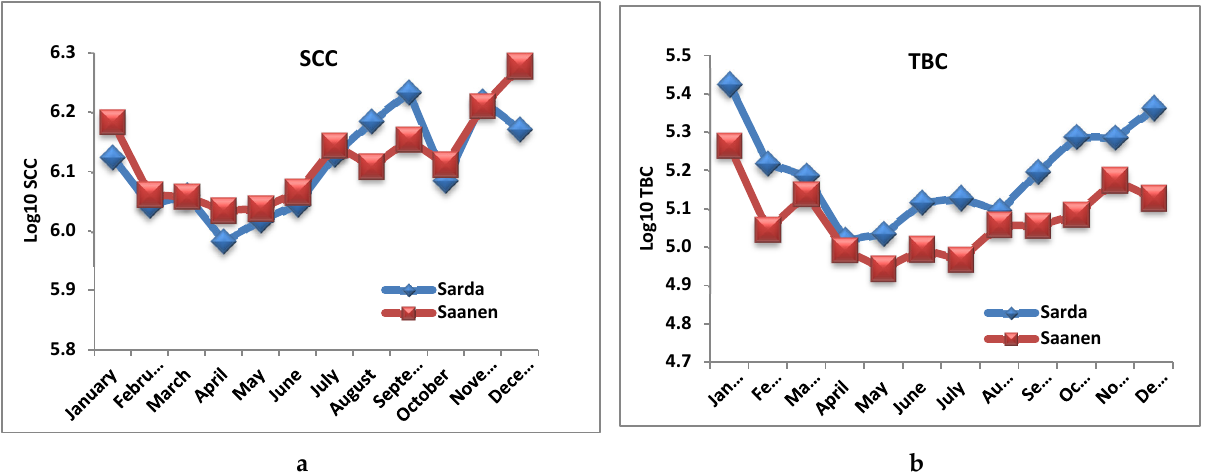
Figure 5. Monthly mean contents of: ( a ) log 10 SCC (decadic logarithm of somatic cell count); ( b ) log 10 TBC (decadic logarithm of total bacterial count). Data are reported for the Sarda (blue line and diamonds) and Saanen (red line and squares) groups of milk samples.